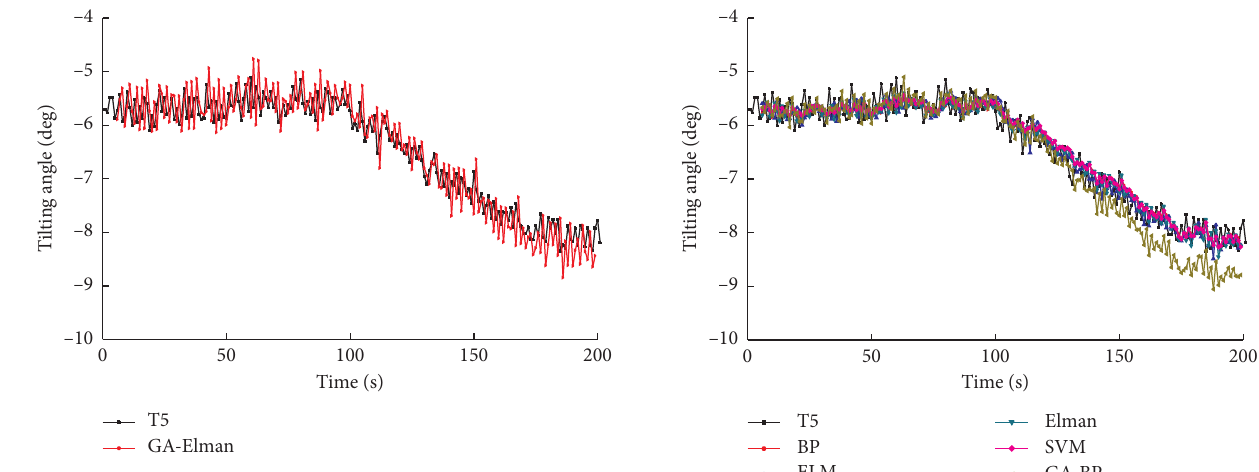
Figure 15: Fitting inclination angles through GA-Elman model.